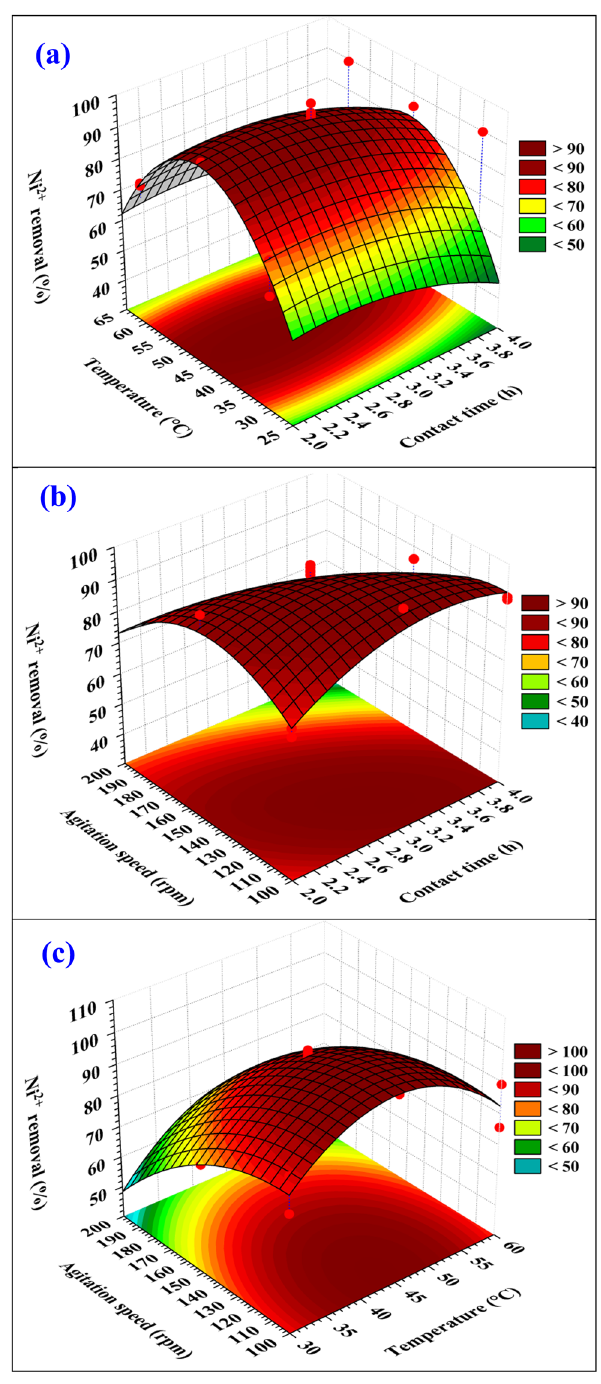
Figure 3: Three - dimensional surface plot for biosorption of Ni 2 + ions by G. amansii biomass from aqueous solution, showing the inter - active e ff ects of the three tested variables: ( a ) agitation speed, ( b ) temperature, and ( c ) contact time was held at their